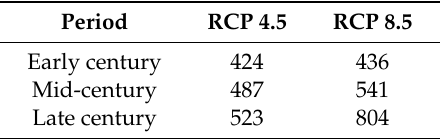
Table 1. Projected concentration of CO 2 in